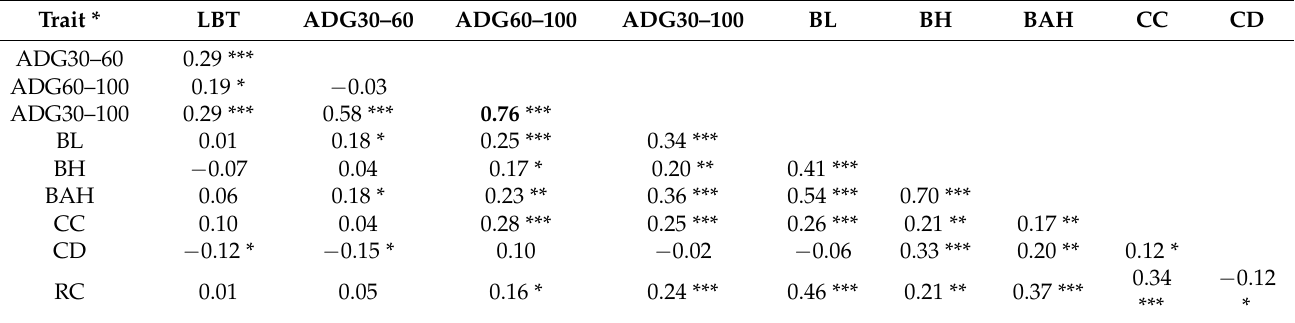
Table 1. Phenotypic correlation coefficients among ten growth traits in crossbred pigs.